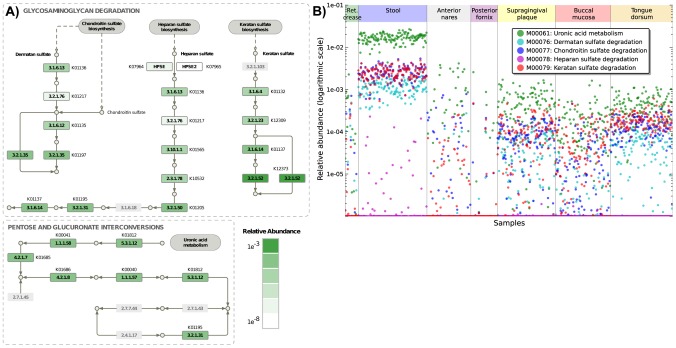
Gene- and module-specific reconstruction of glycosaminoglycan degradation specific to the gut microbiota.A) Individual gene family abundances for four gut-specific high abundance modules: chondroitin, dermatan, and keratan sulfate degradation (glycosaminoglycan degradation, also including heparan sulfate), and uronic acid metabolism (occurring directly downstream in the pentose and glucuronate interconversion pathway). Relative abundance is shown from dark (high) to light (low) green, averaged over 136 stool microbiomes, with enzymes not present in the KEGG Orthology in gray. Heparan degradation is absent specifically due to the lack of heparanase (K07964-5), but no one gene family is otherwise responsible for the high abundances of the remaining four modules in the gut, despite several shared enzymes (e.g. beta-glucuronidase, K01195). B) Relative abundances of all five modules in all body habitats and samples, demonstrating gut-specific prevalence. Despite the close connections among these pathways, they show distinct patterns of relative abundance specific to the gut and covary at very low abundance in the oropharynx.